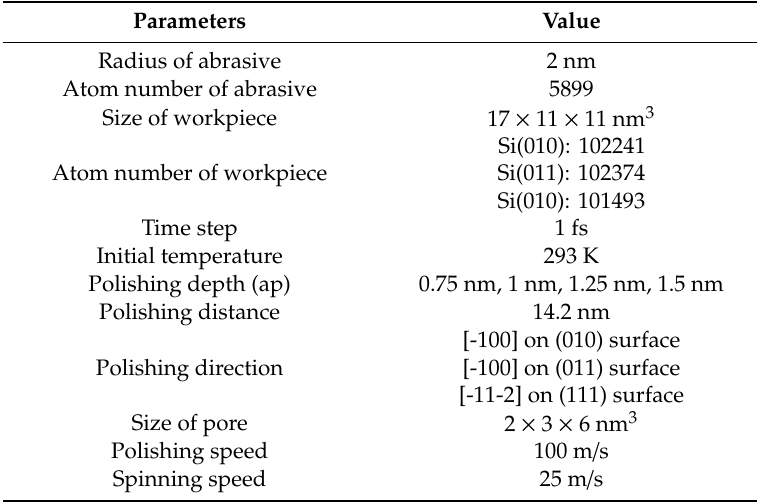
Table 1. MD (molecular dynamics) simulation parameters in 3D